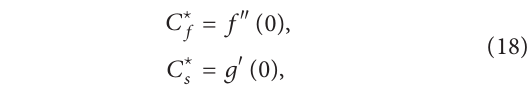
Table 1: Table of comparison showing authors and the special cases of our model